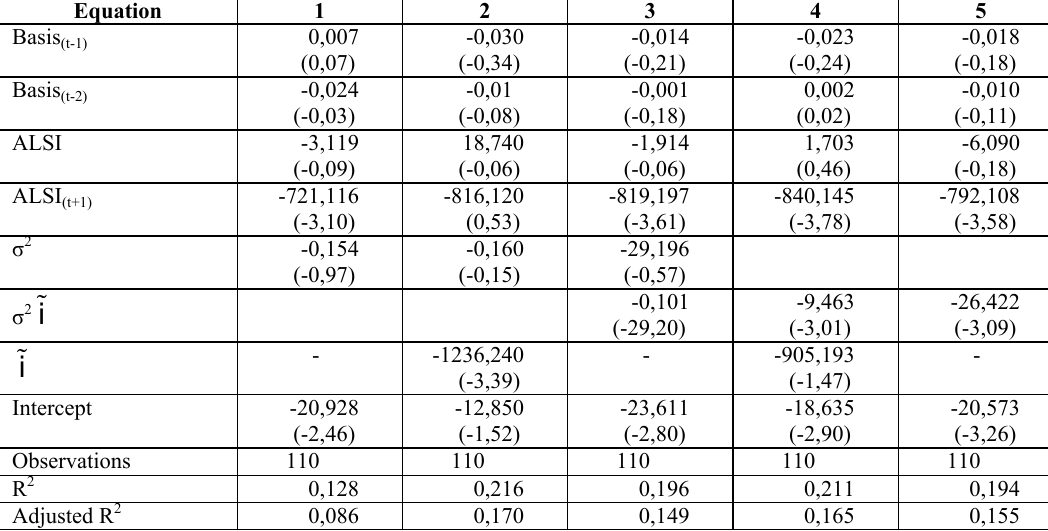
Table 2: Daily regressions of implied volatility on basis – ALSI